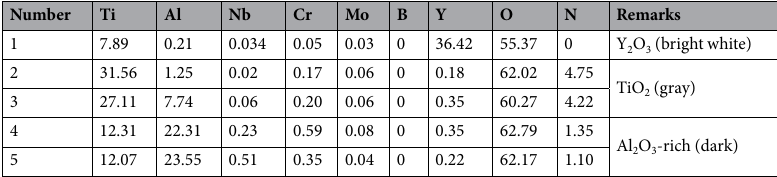
Table 2. Elemental composition (at.%) determined via EPMA at 1–5 points in Fig. 3(b).